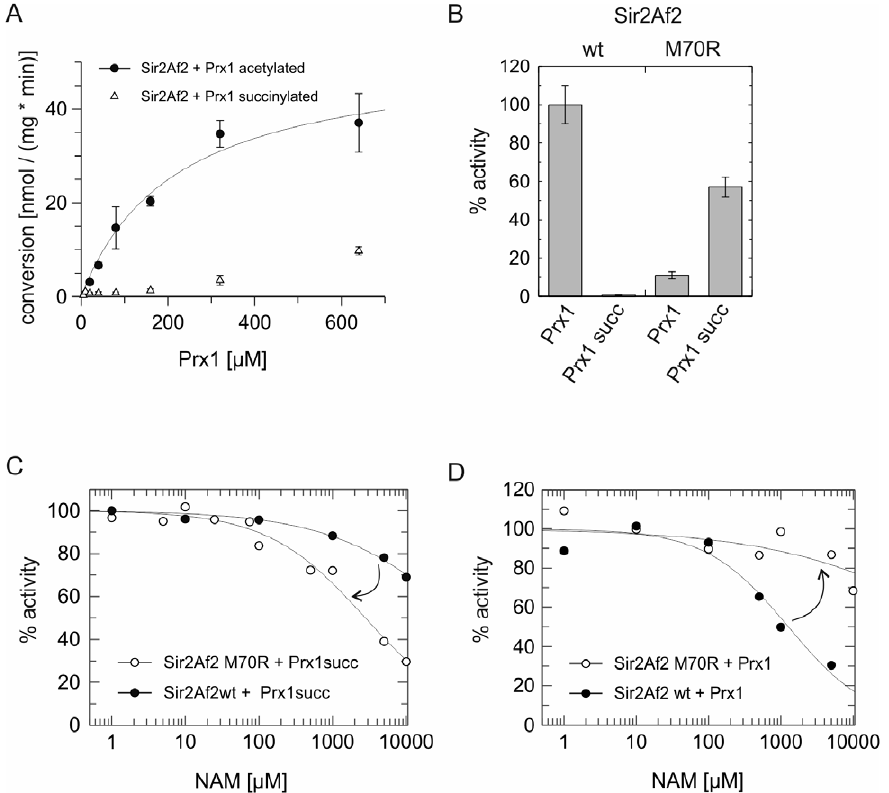
N Figure 5. Role of Sir2Af2-Met70 in deacylation specificity and nicotinamide sensitivity. ( A ) Substrate concentration dependent activity of ) and succinylated ( D ) Prx1-Lys197 peptides determined using the mass spectrometry assay. Error bars represent Sir2Af2 against acetylated ( standard errors of linear fits to time-series measurements. ( B ) Comparison of Sir2Af2 activities against acetylated and succinylated Prx1-Lys197 N peptide, determined using mass spectrometry and normalized against wt deacetylation activity. Error bars represent standard errors of linear fits to ) and Met70Arg variant ( # ) activity against (C) succinylated and time-series experiments. ( C + D ) Nicotinamide-dependent inhibition of Sir2Af2 wt ( (D) acetylated Prx1-Lys197 peptide, determined using mass spectrometry and normalized against activity in absence of nicotinamide. The effect of exchanging Met70 to Arg is indicated by arrows. Prx1succ, succinylated Prx1-Lys197 peptide; NAM, nicotinamide.